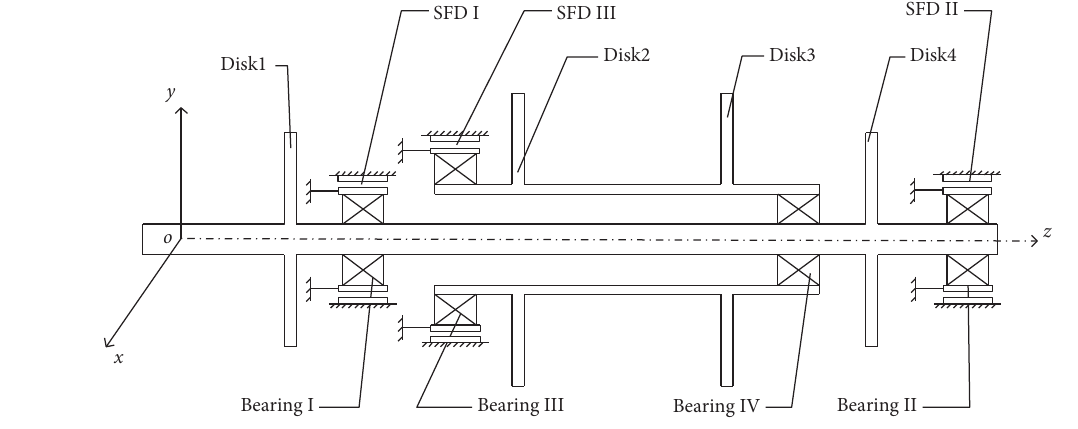
Figure 12: Structural diagram of the dual rotor system. Table 5: Inertial properties and unbalance configuration of disks.